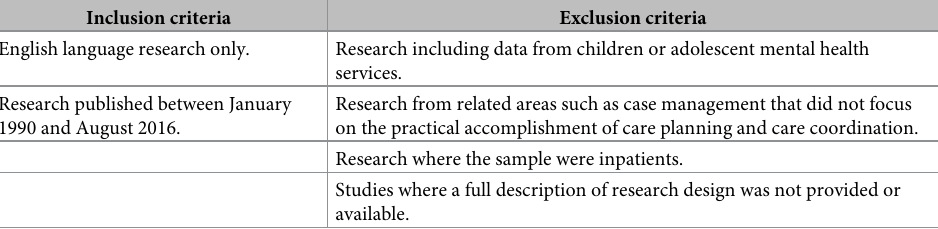
Table 1. Inclusion and exclusion criteria used to guide the search of literature. Inclusion criteria Exclusion